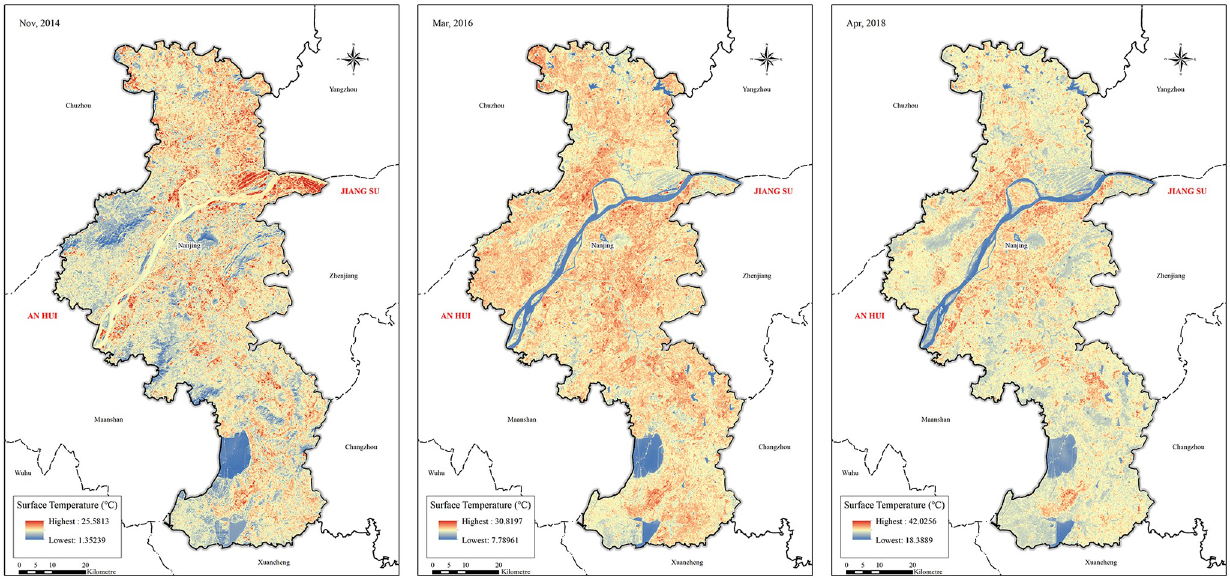
Fig 2. A spatial distribution map of heat field in Nanjing in 2014(a), 2016(b), 2018(c). The values of heat island intensity were calculated based on satellite image taken from Geospatial Data Cloud, Landsat8OLI_TIRS.